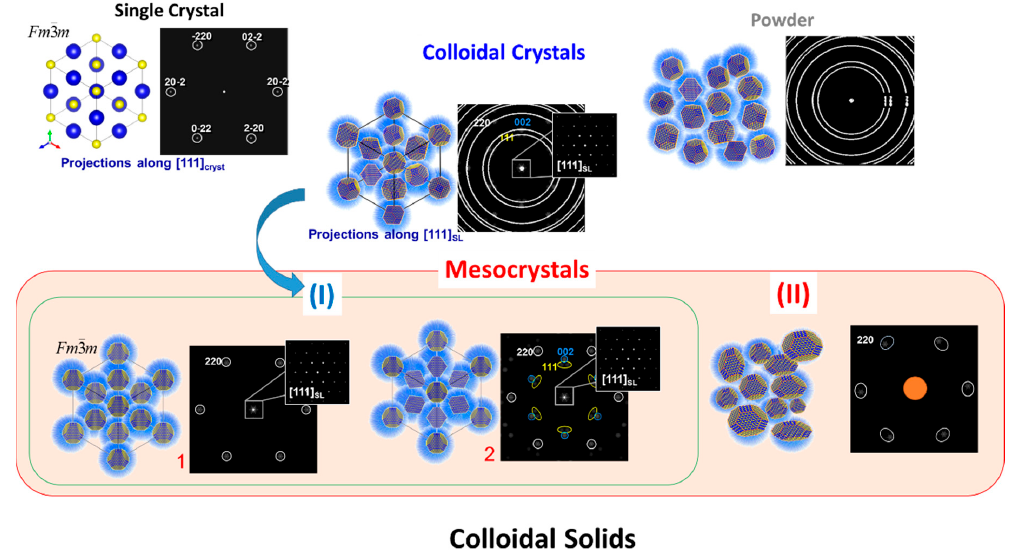
Figure 4. Schematic illustration of different types of crystalline materials with the corresponding diffraction patterns. For illustrational purposes the crystalline material (nanoparticles) has rock salt type crystal structure (S.G. Fm -3 m ) and in case of colloidal crystals the crystalline nanoparticles are stabilized by organic molecules (blue shell) and arranged in a face-centered cubic ( fcc ) superlattice (S.G. Fm -3 m ). ( Top row ) Single crystal, disordered colloidal aggregates e.g., “powder”, colloidal crystal with the corresponding diffraction patterns. ( Bottom row ) Mesocrystals (red frame): type I (green frame)—colloidal crystals with mutually oriented monodisperse nanocrystals (characterized by a single crystal-like diffraction pattern in the small angle region and a single crystalline (1) or texture-like (2) pattern in the wide angle region); type II—colloidal aggregates with mutually oriented polydispersed nanocrystals with a possible certain degree of orientational mismatch.